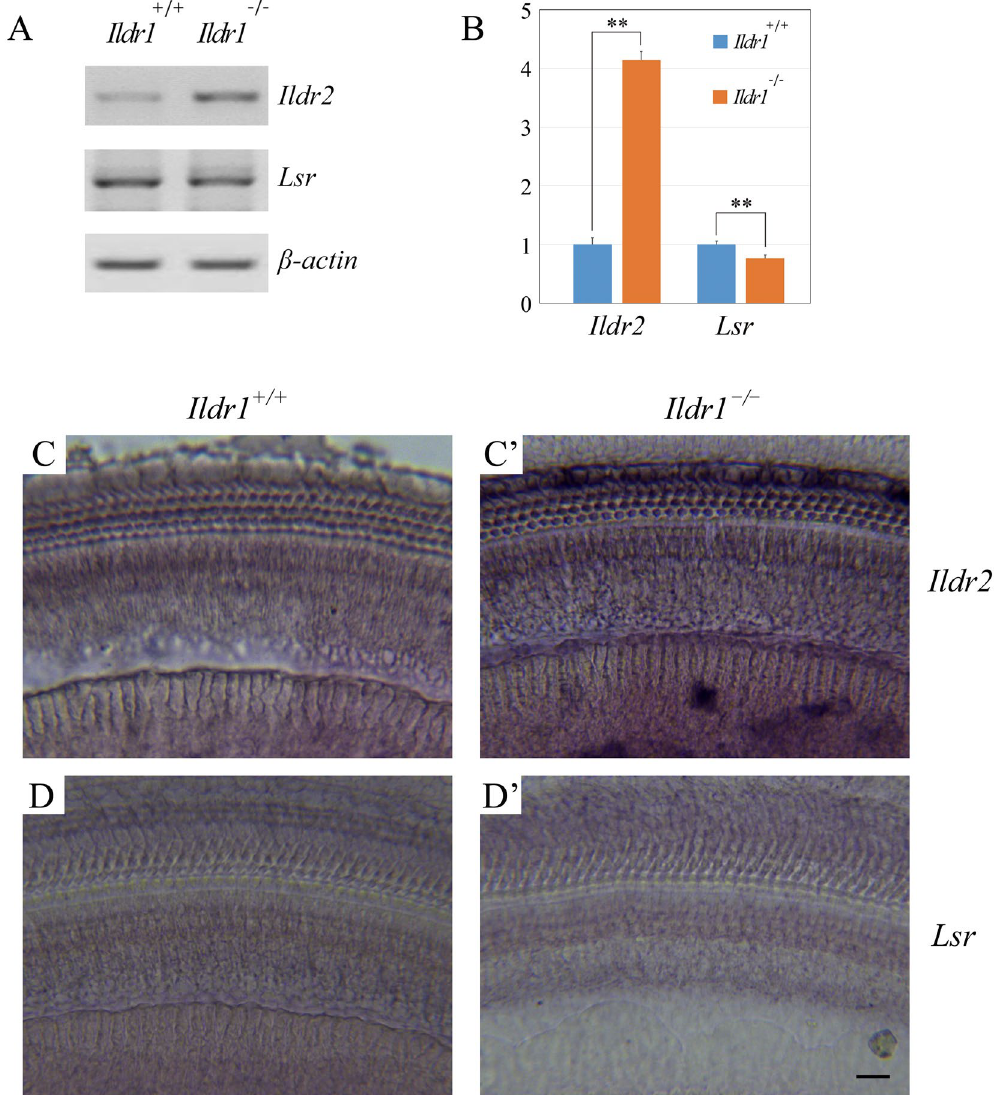
Figure 4. Ildr2 is upregulated in Ildr1 knockout mice. ( A ) RT-PCR revealed that Ildr2 , but not Lsr , is upregulated in Ildr1 knockout mice. β -actin was included as internal control. ( B ) Quantitative real-time PCR revealed that Ildr2 , but not Lsr , is upregulated in Ildr1 knockout mice. The differences between groups were determined by Student’s t-test. ** P < 0.01. ( C – D’ ) In situ hybridization showed that Ildr2 and Lsr are expressed in mouse cochlea, and Ildr2 expression is upregulated in Ildr1 knockout mice. Scale bar: 15 μ